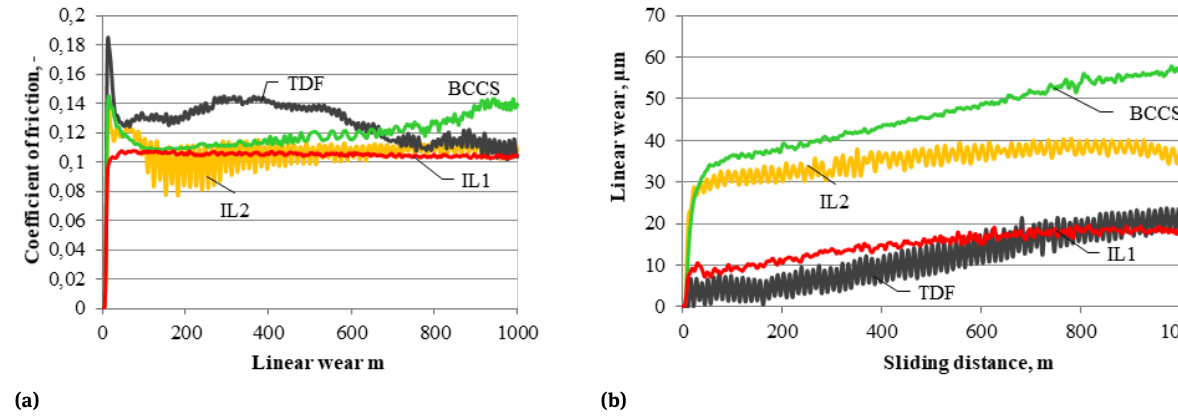
Figure 5: Tribological characteristics depending on the lubricant: a) coeflcient of friction, b) linear wear.